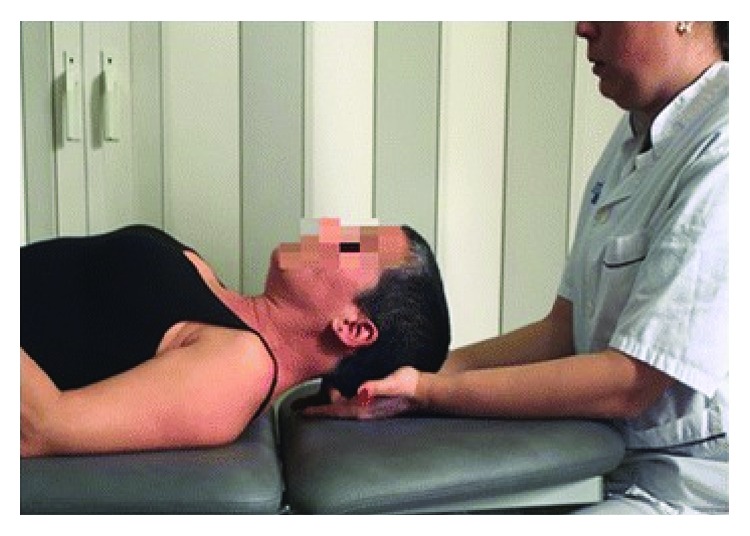
The technique relaxing the suboccipital muscles [60].